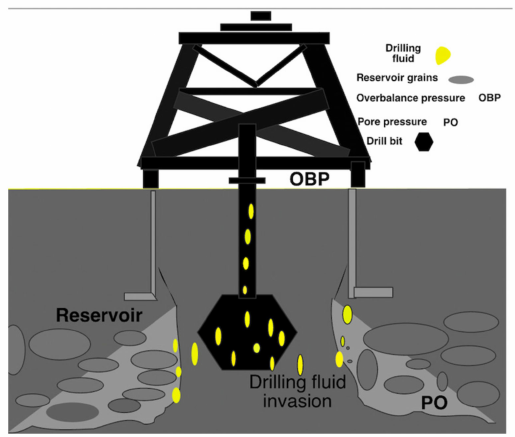
Figure 3. Drilling fluid invasion formation damage reactions caused by overbalance